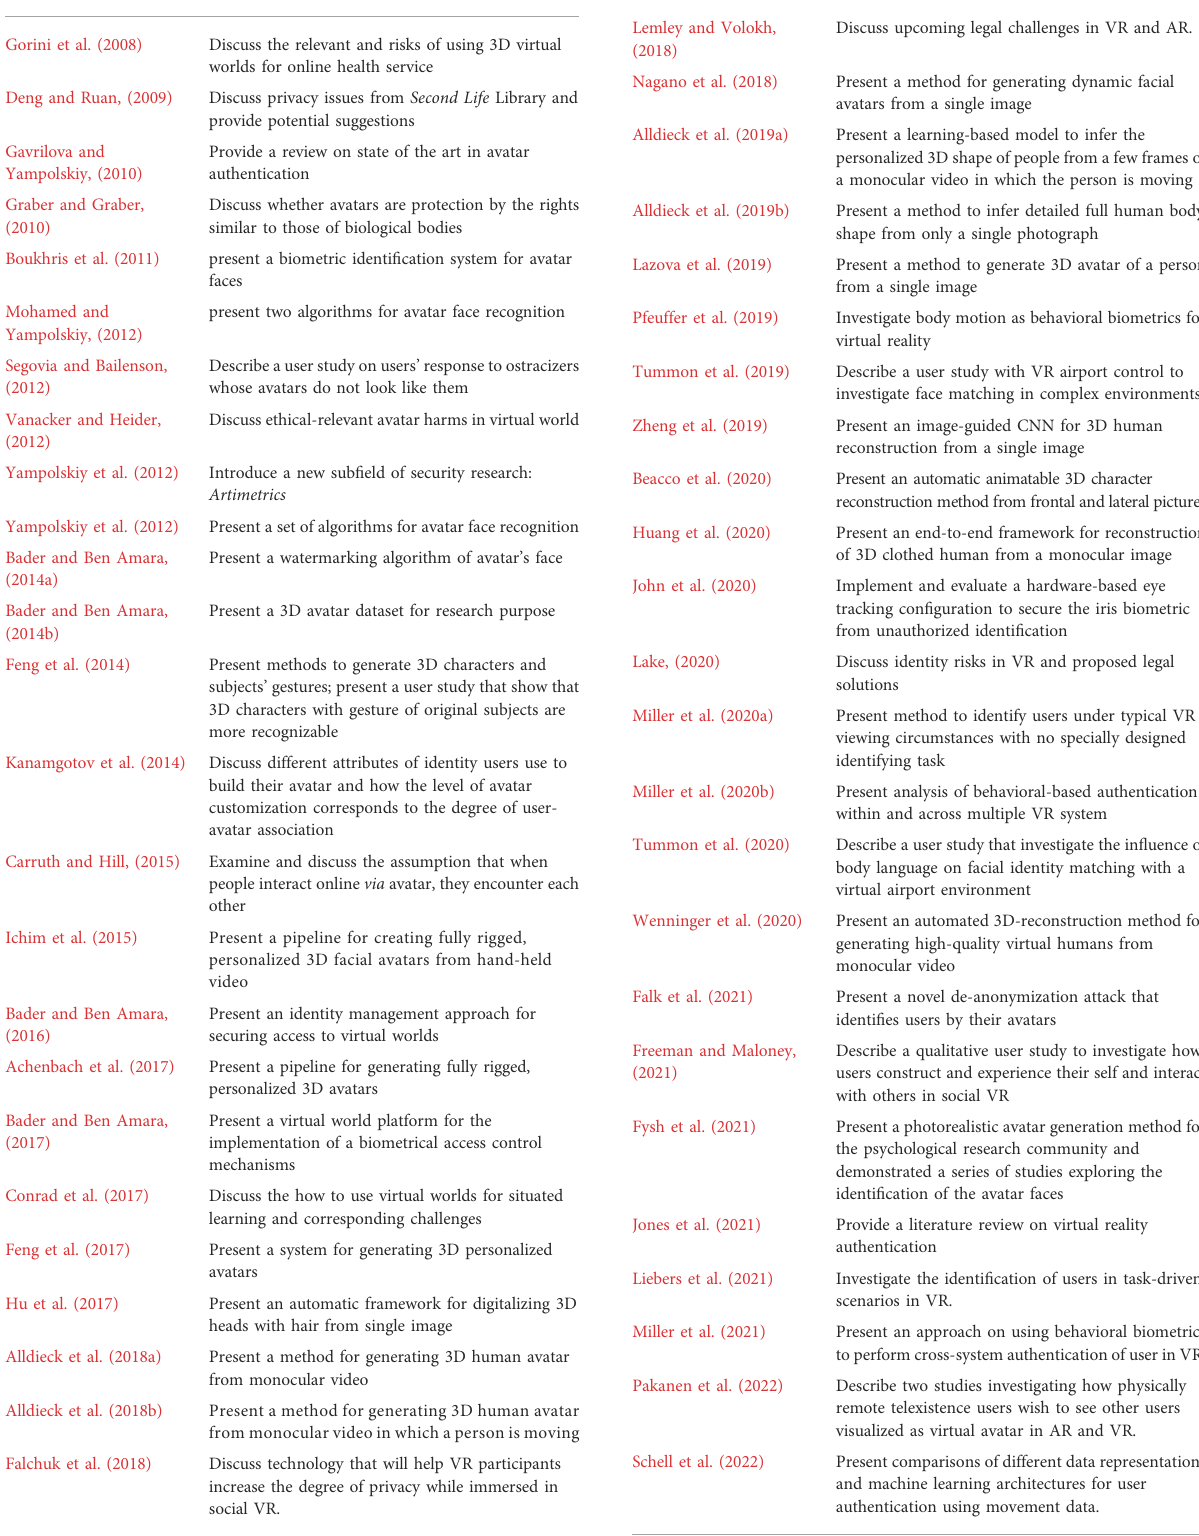
TABLE 2 Overview of selected